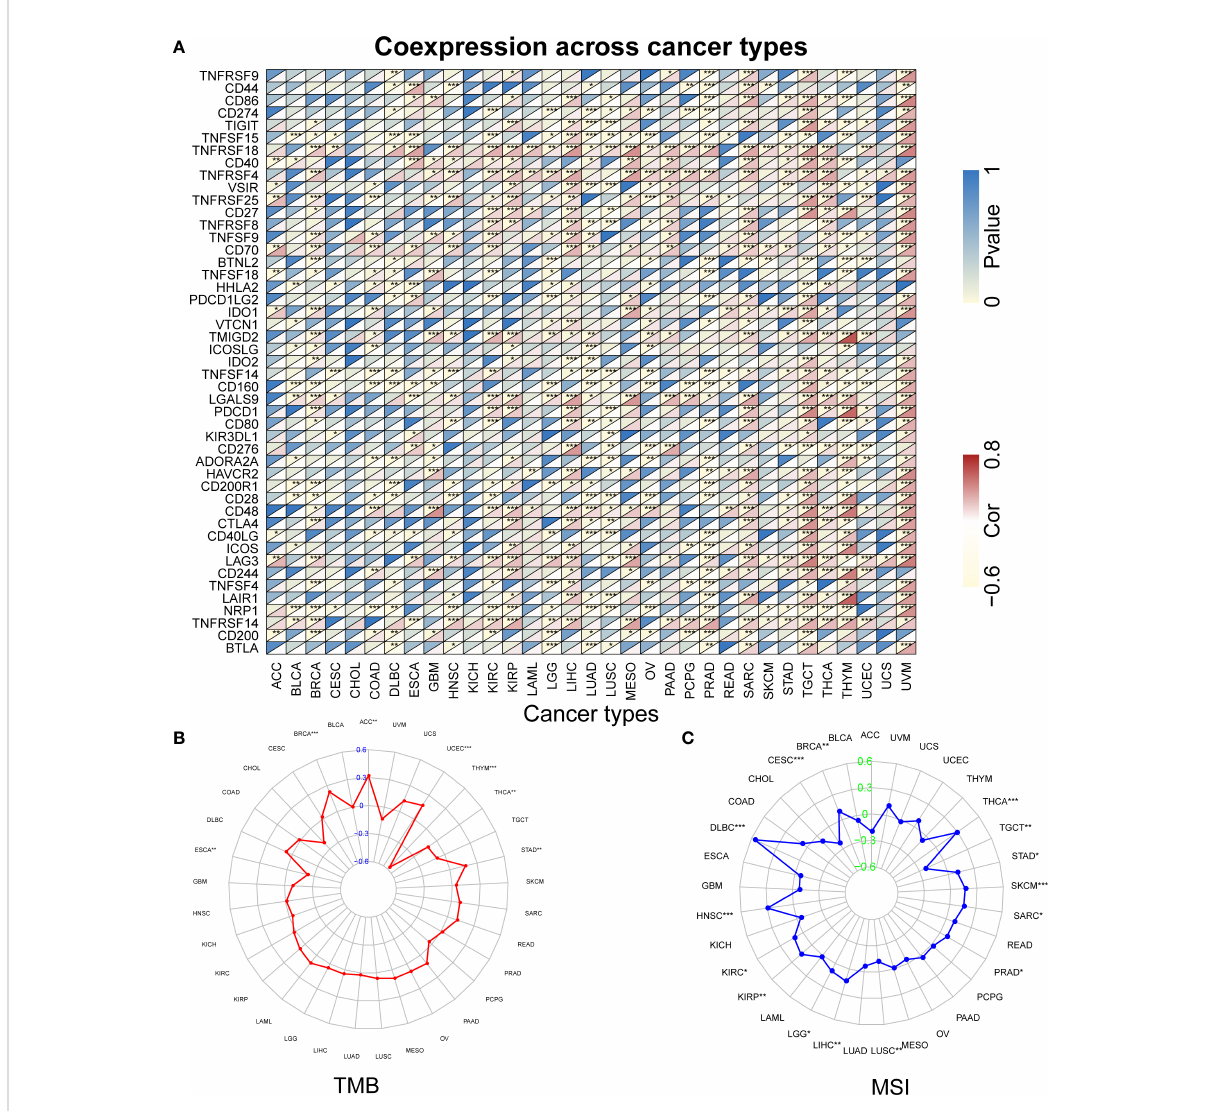
FIGURE 8 The relationship between RBX1 and immune checkpoints, TMB and MSI based on TCGA database. (A) Heatmap illustrating the relationship between RBX1 and known immune checkpoints. The top left triangle represents the P-value, and the bottom right triangle represents the correlation coef fi cient. Correlation between RBX1 and TMB (B) and MSI (C) . * P < 0.05, ** P < 0.01, and *** P <